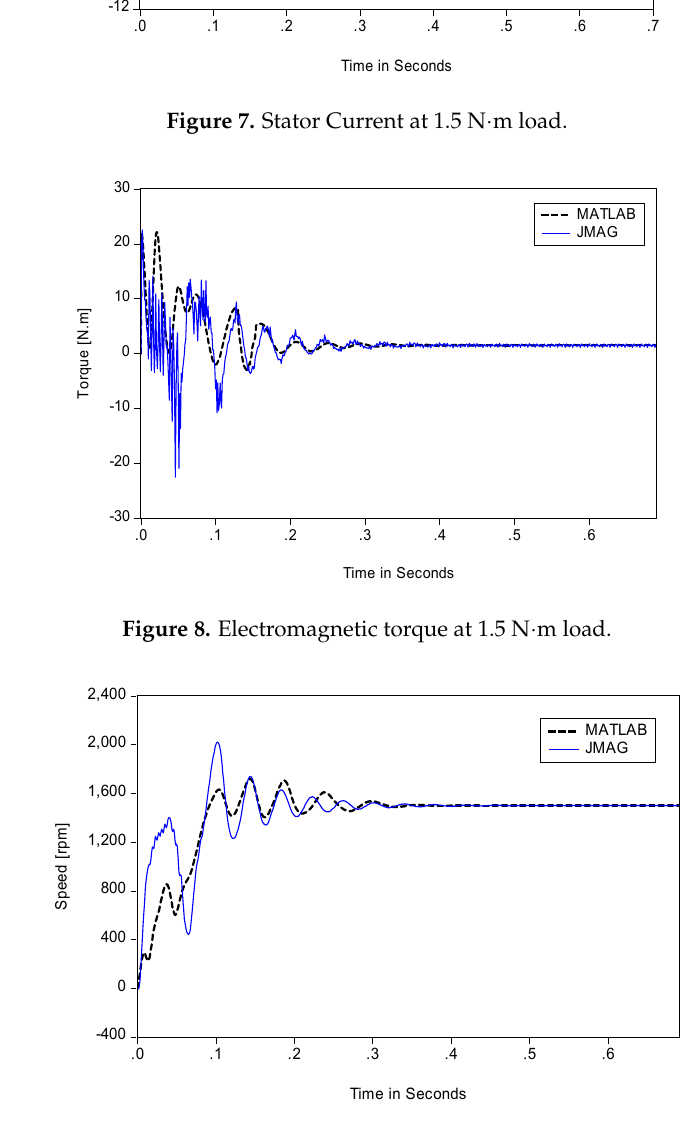
Figure 10. Stator Current for a load of 2.1 N ∙ m and 19% eccentricity. Figure 11 shows a comparison between the healthy and faulty stator currents under 19% SE and a load of 2.1 N ∙ m. It is quite clear that under this degree of SE, it takes a longer time to attain a steady state value than a healthy condition Also, higher current peaks are presented in the transient region. -15-10-5051015 .0